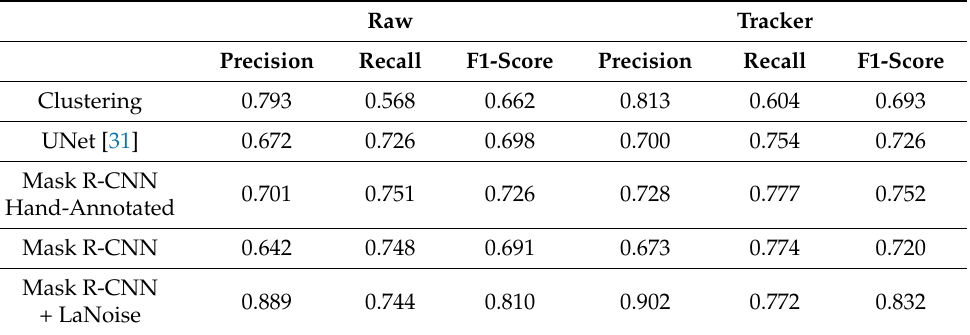
Table 3. The performance of the detectors on data collected during adverse weather conditions. The heavy precipitation causes the recall to suffer across the board, while the proposed Mask R-CNN + LaNoise method maintains a good level of precision, resulting in a significantly improved F1-score compared to the other methods. Raw Tracker Precision Recall F1-Score Precision Recall F1-Score Clustering 0.793 0.568 0.662 0.813